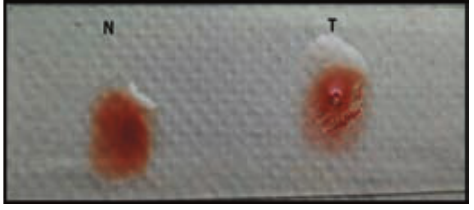
Fig. 2. Spot haemagglutination test N: Negative control